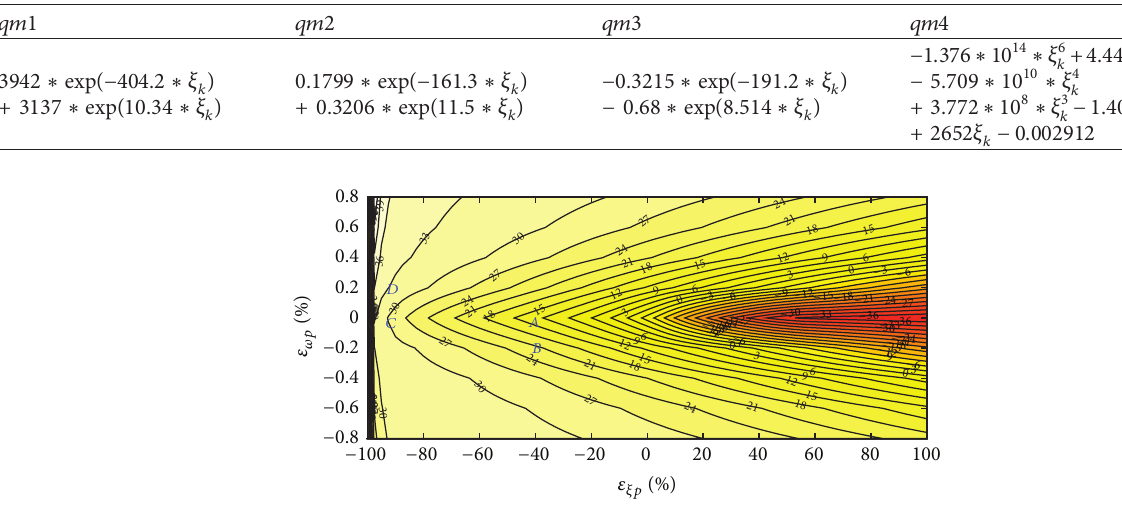
Figure 29: 𝜀 (61) for Mode 3 of Table perf